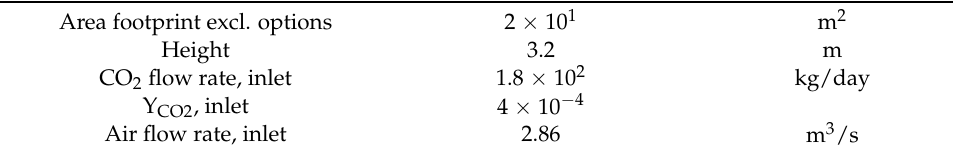
Table 6. Data of one adsorbent bed